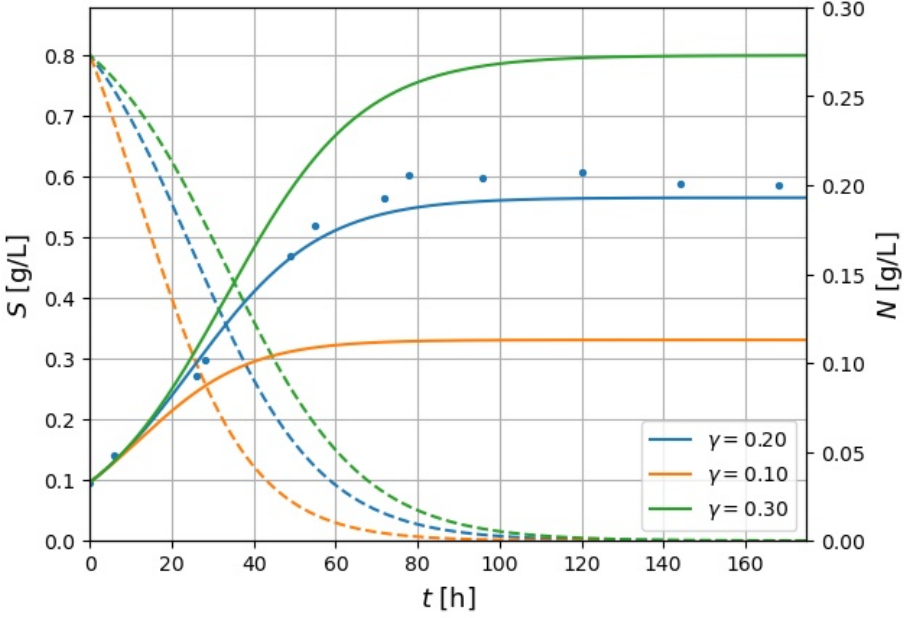
Figure 5. Sensitivity of bacterial concentration on the inner parameter γ ( a = 60 g/L and r m = 4 h − 1 ). Blue dots correspond to experimental data.